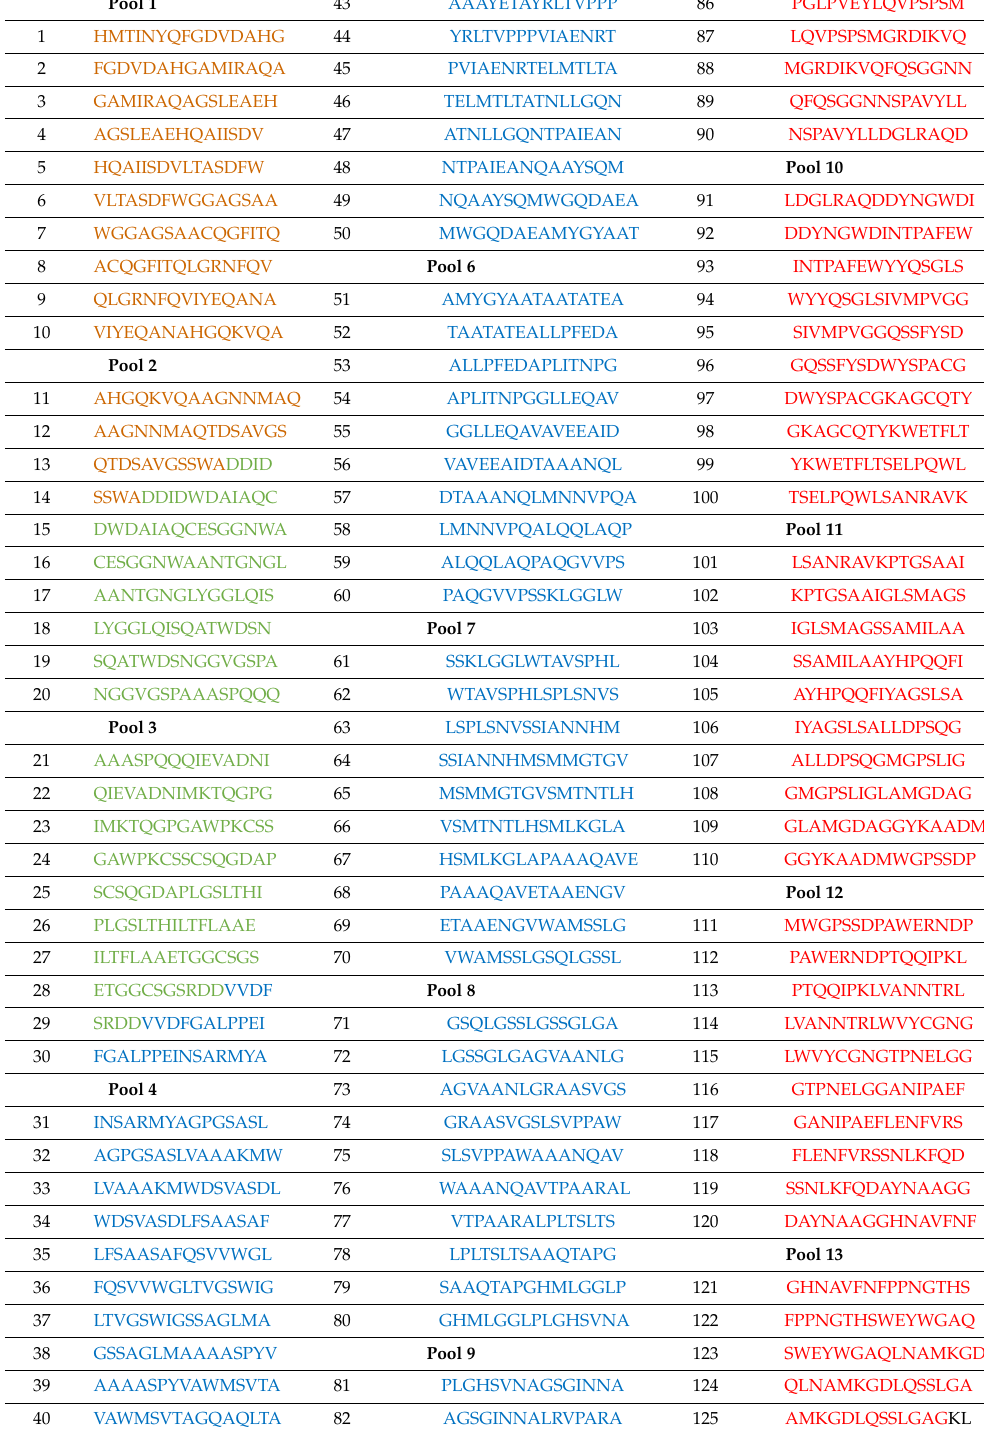
Table 1. ID91 peptide pool composition used for peptide stimulation of